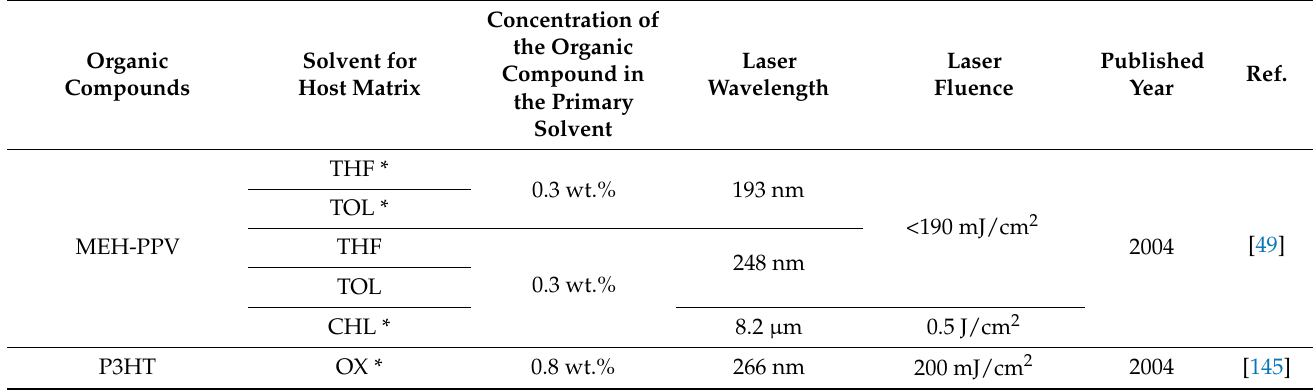
Table 1. Organic thin films deposited using MAPLE-based techniques for PV applications: the organic compounds deposited as layers, the solvents used as a host matrix, concentration of the organic compound, laser wavelength and laser fluence used in the MAPLE deposition, the year when the work was reported (based on the data from the literature